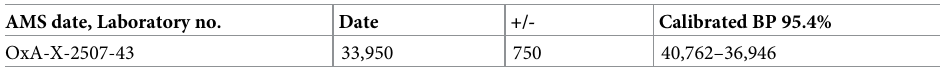
Table 3. Radiocarbon dating on a charcoal sample from layer 21 by the oxford radiocarbon accelerator unit. The calibrated ages are given as 95.4% probability